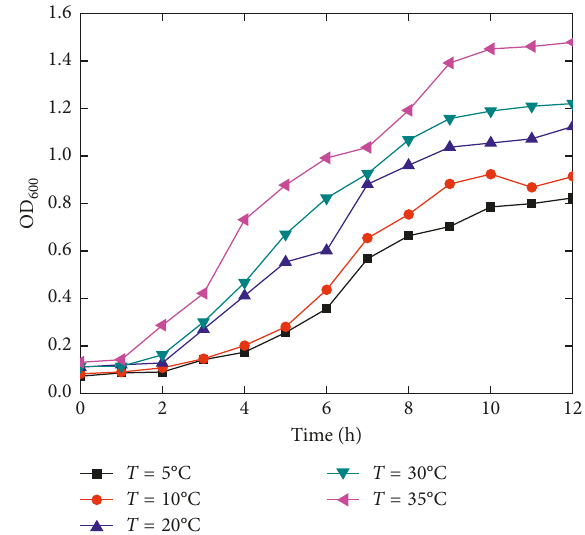
Figure 3: The OD 600 value of the bacteria solution at different temperatures.